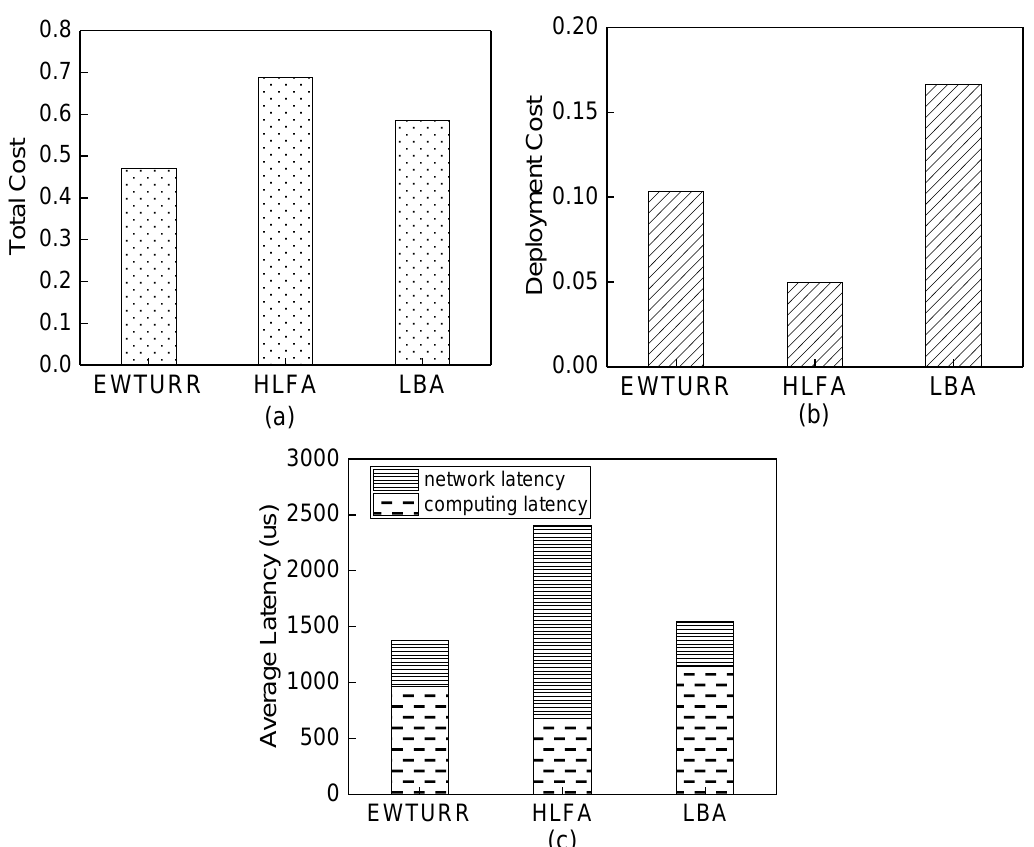
Figure 9. Performance illustration of approximate algorithm, heaviest-location first algorithm (HLFA) and latency-based algorithm (LBA) ( a ) Comparisons of total cost under different algorithms. ( b ) Comparisons of deployment cost under different algorithms. ( c ) Comparisons of average latency under different algorithms.